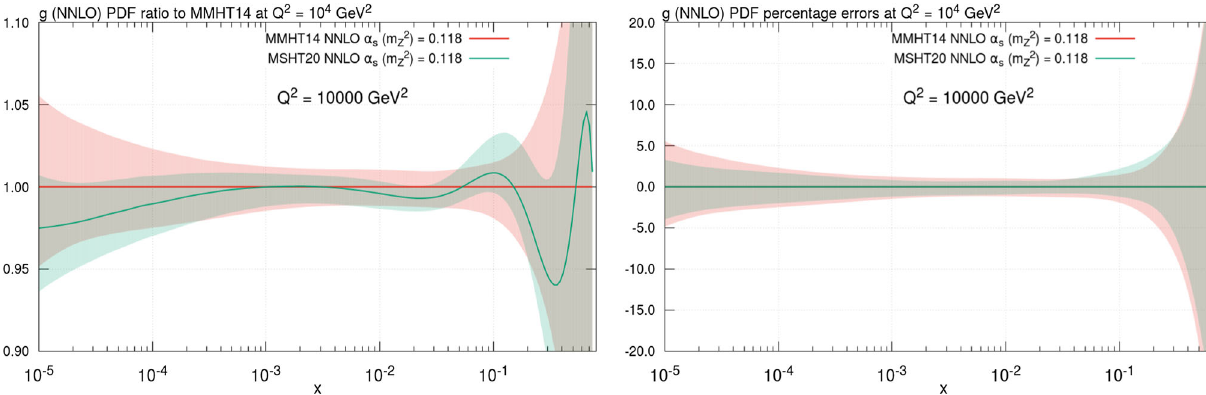
Fig. 17 Gluon PDF for MSHT20 and MMHT14, at NNLO and Q 2 = 10 4 GeV 2 . (Left) ratio to MMHT14. (Right) percentage